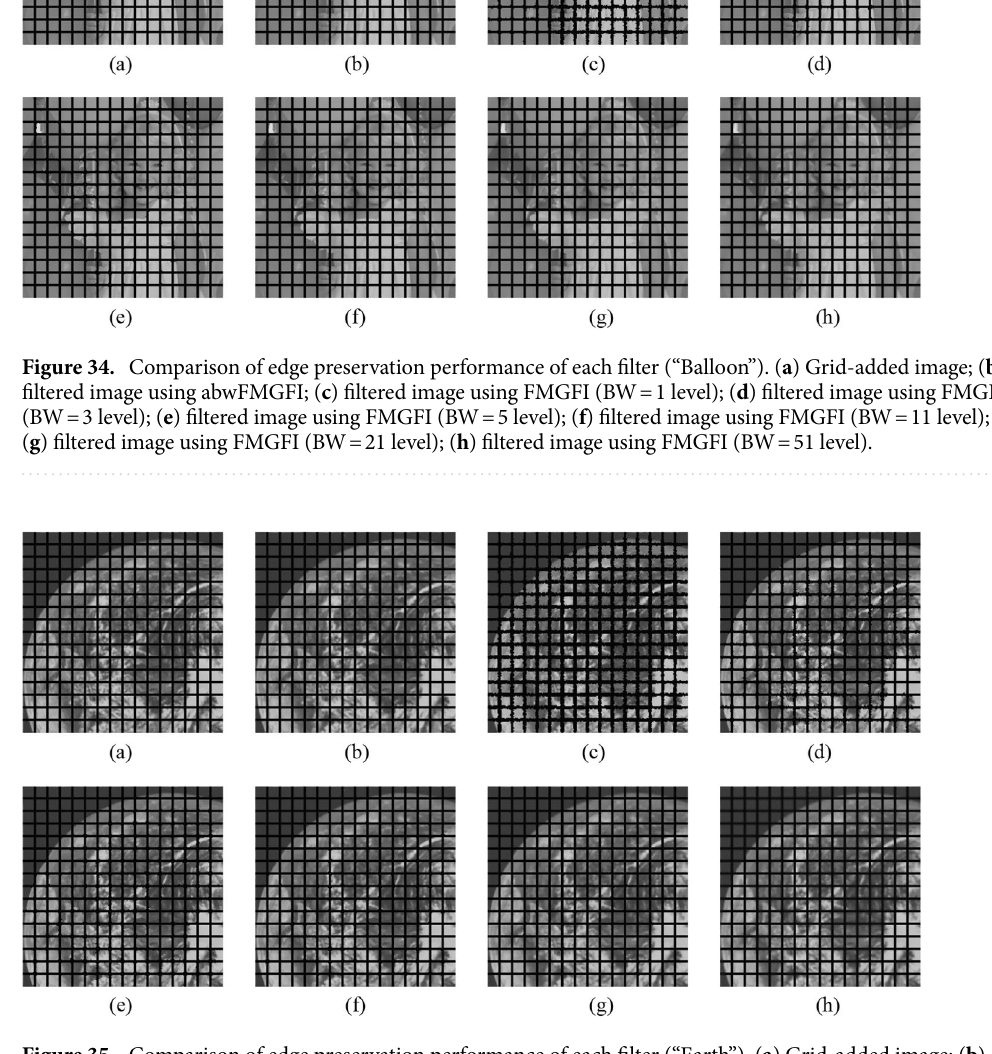
Figure 35. Comparison of edge preservation performance of each filter (“Earth”). ( a ) Grid-added image; ( b ) filtered image using abwFMGFI; ( c ) filtered image using FMGFI (BW = 1 level); ( d ) filtered image using FMGFI (BW = 3 level); ( e ) filtered image using FMGFI (BW = 5 level); ( f ) filtered image using FMGFI (BW = 11 level); ( g ) filtered image using FMGFI (BW = 21 level); ( h ) filtered image using FMGFI (BW = 51